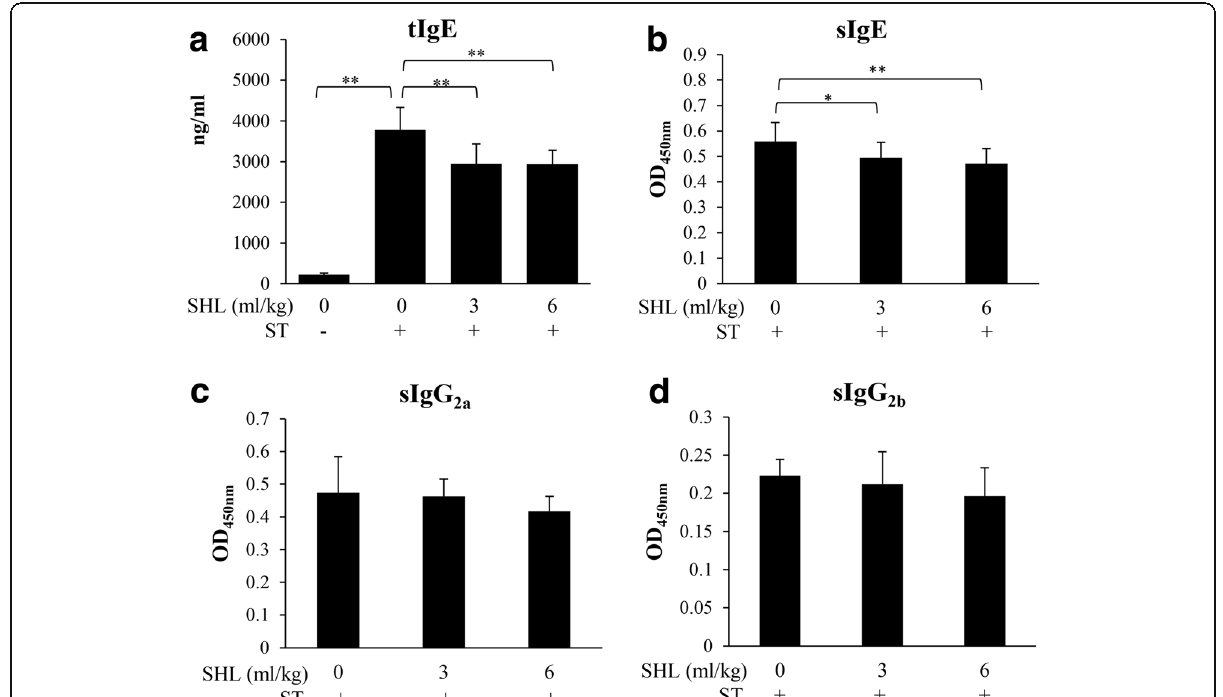
Fig. 1 Effects of SHL on the serum tIgE ( a ), sIgE ( b ), sIgG 2a ( c ) and sIgG 2b ( d ) productions in the ST-sensitized mice. Mice were intraperitoneally immunized with ST (60 μ g/mouse) once a week. SHL (3 mL/kg or 6 mL/kg, i.g.) was daily administrated daily to the mice. 4 weeks later the mice were sacrificed and the sera were collected. The serum tIgE was determined by a commercial ELISA kit. The sIgE, sIgG 2a and sIgG 2b levels were assayed by our established ELISA. The data represent the means ± SD ( n = 10). * P < 0.05 and ** P <